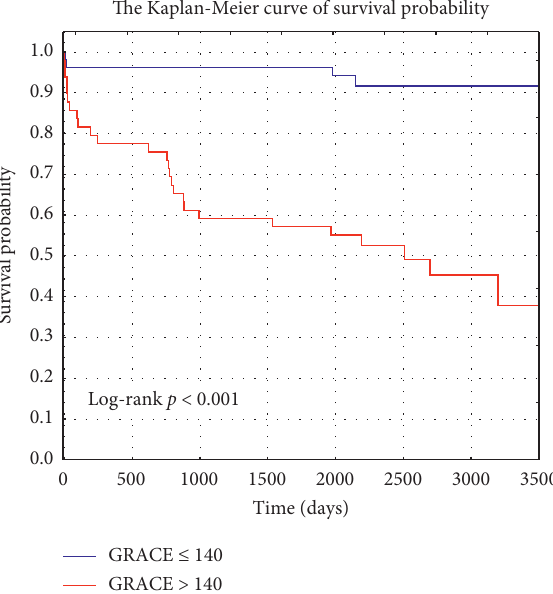
Figure 1: The Kaplan–Meier curve of survival probability of patients with Takotsubo ( n � 101).